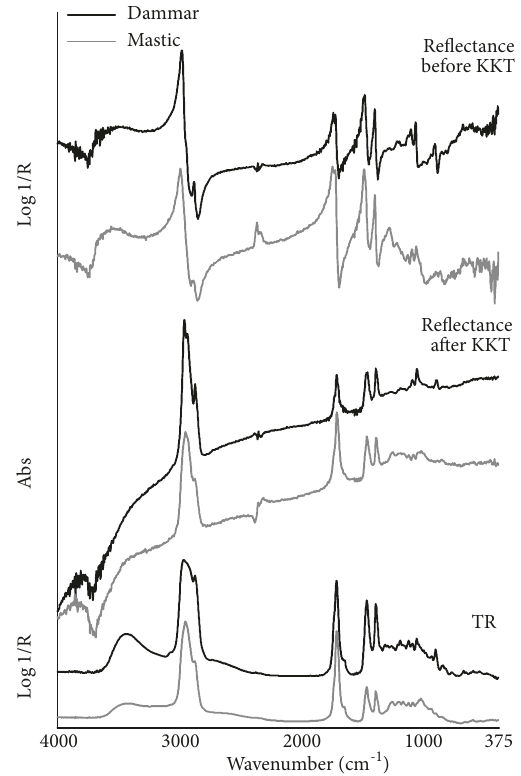
Figure 7: FTIR spectra in the mid-infrared region of the studied triterpenoid resins (black line: dammar, gray line: mastic) using different analysis modes. From top to bottom: total reflection mode before the KKT correction, total reflection mode after the KKT correction, and transflection mode.